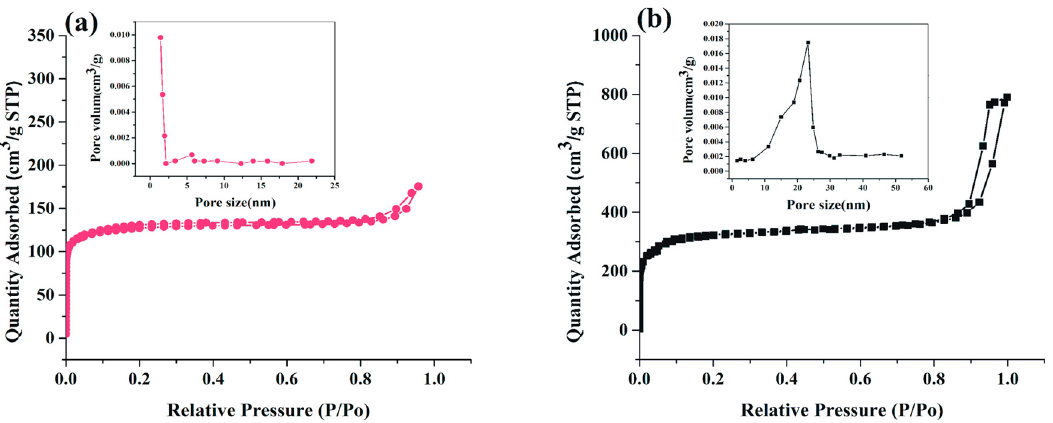
Figure 5. Nitrogen gas adsorption/desorption isotherms and pore size distributions for ( a ) hexahedral ZIF-8 and ( b ) hierarchical ZIF-8.